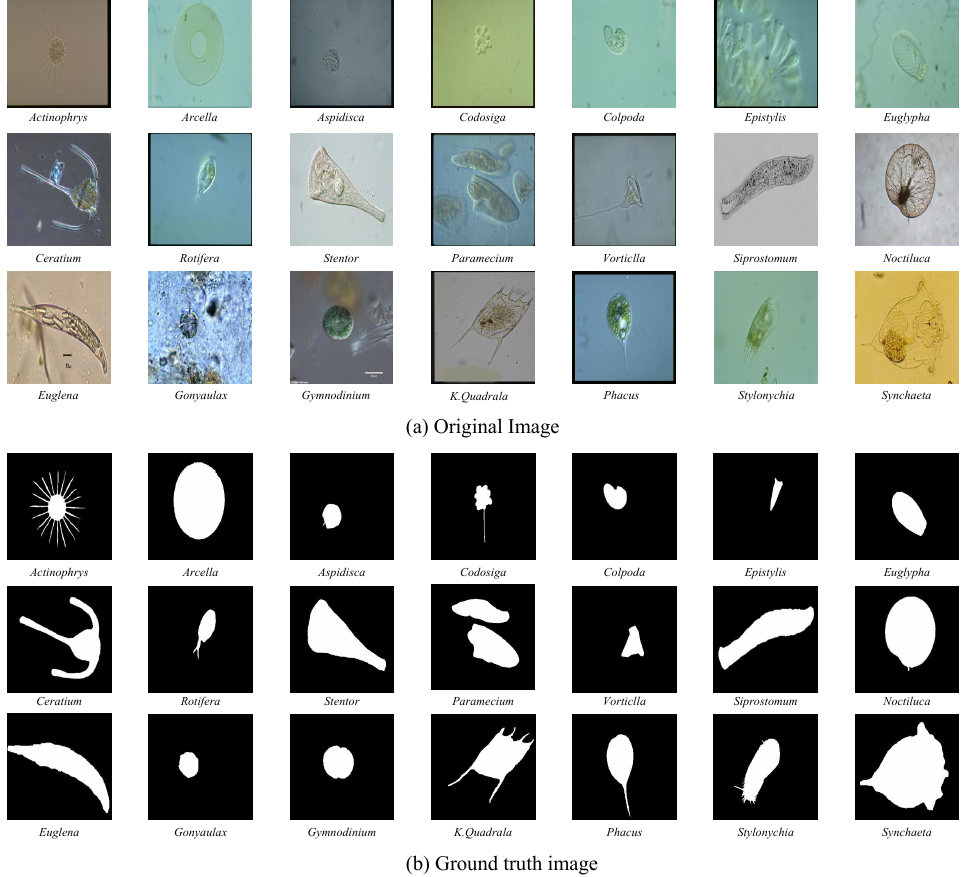
Figure 3. Examples of the environmental microorganism image in EMDS-5. ( a ) is the original images of EMDS-5, each image contains one or more EM objects of the same species, and one image is selected for each species as a representative. ( b ) correspond to the real segmentation images of microorganisms in each image in the ( a ). The pixel value of the background part in the microorganism image is set to 0, and the foreground part is set to